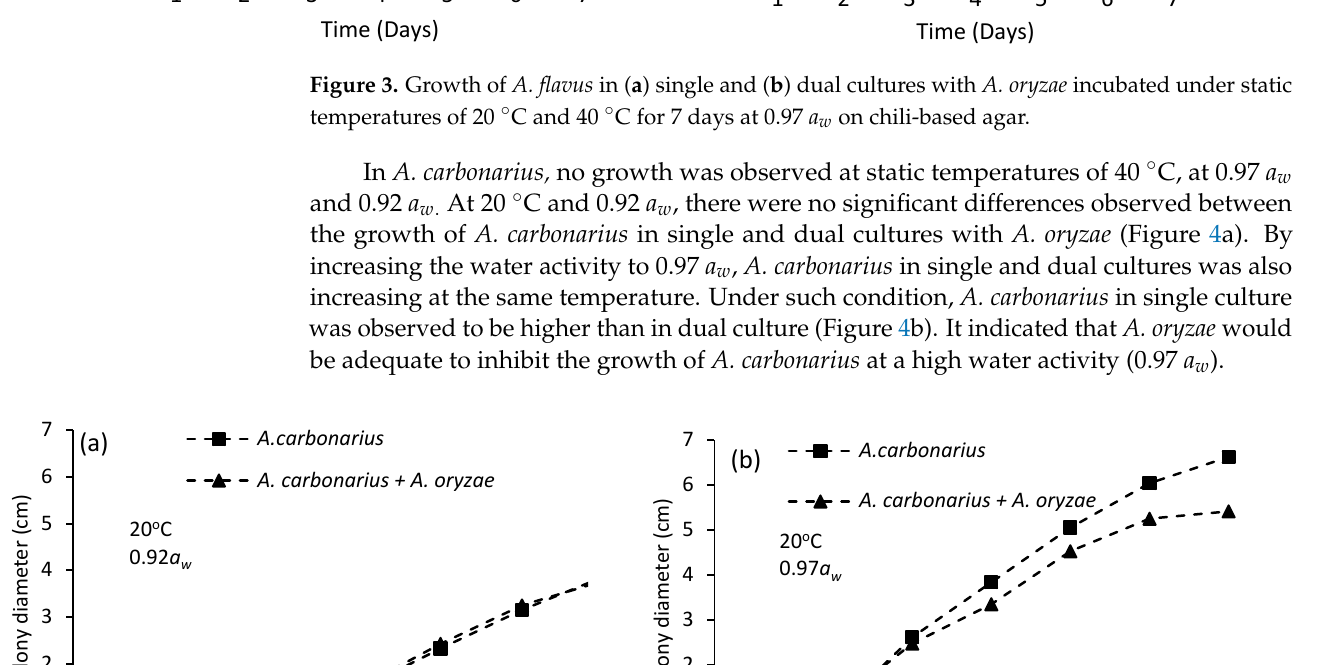
Figure 3. Growth of A. flavus in ( a ) single and ( b ) dual cultures with A. oryzae incubated under static